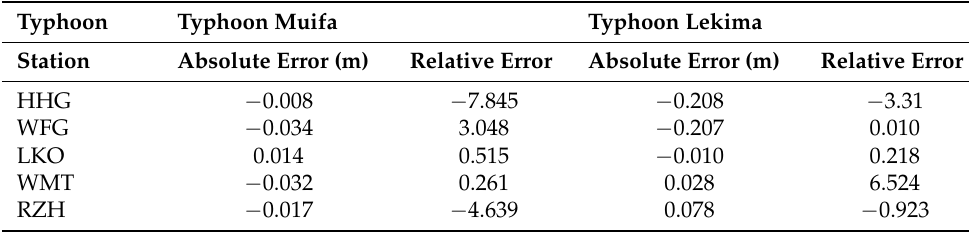
Table 6. The absolute error and relative error between the observed data and ERA5 reanalyzed data for a storm surge at five stations (HHG, WFG, LKO, WMT, and RZH) during Typhoon Muifa and Typhoon Lekima. Significant digits are limited to three decimal